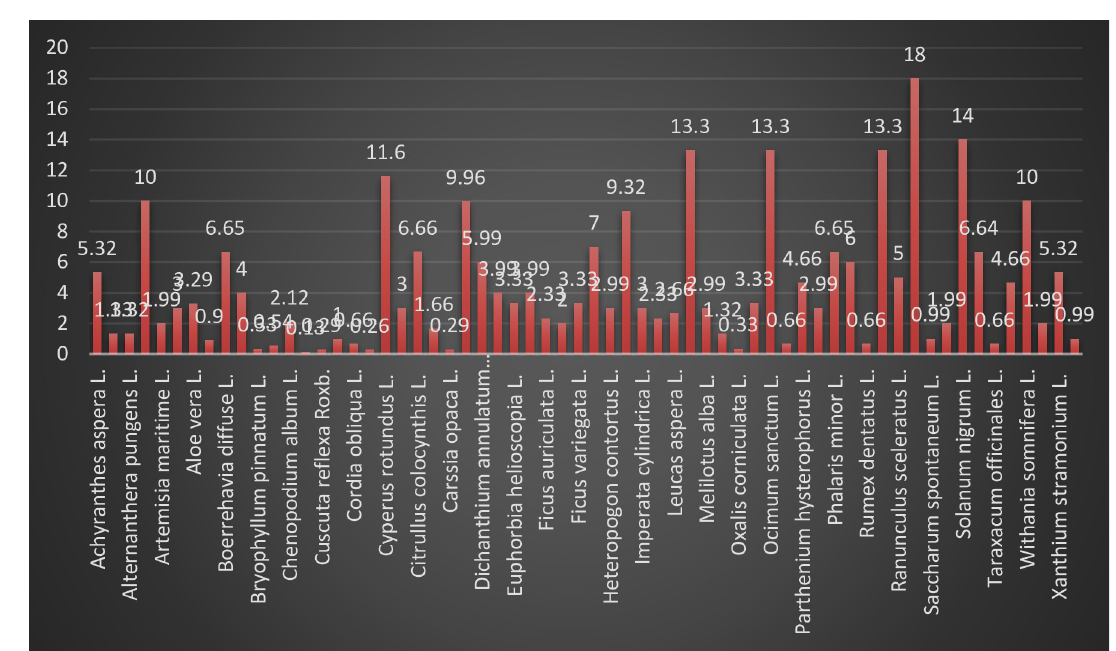
Fig 4. ROP value of indigenous plants species from SMR District Bhimber of AJK, Pakistan.